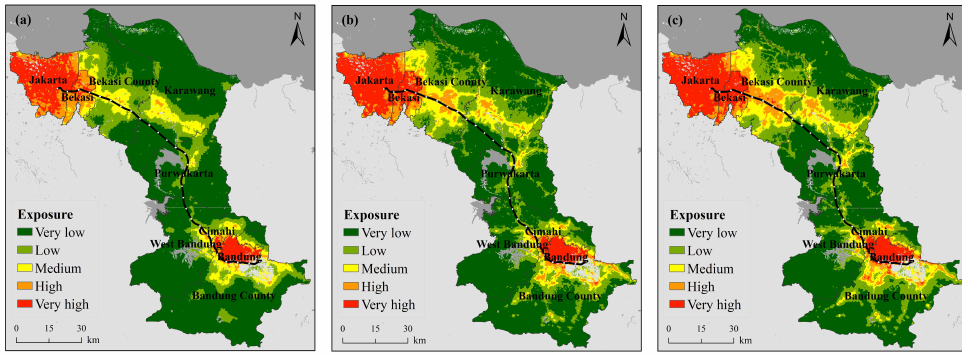
Figure 3. Spatiotemporal variation in the heat wave exposure (( a ) 2005, ( b ) 2014, ( c )